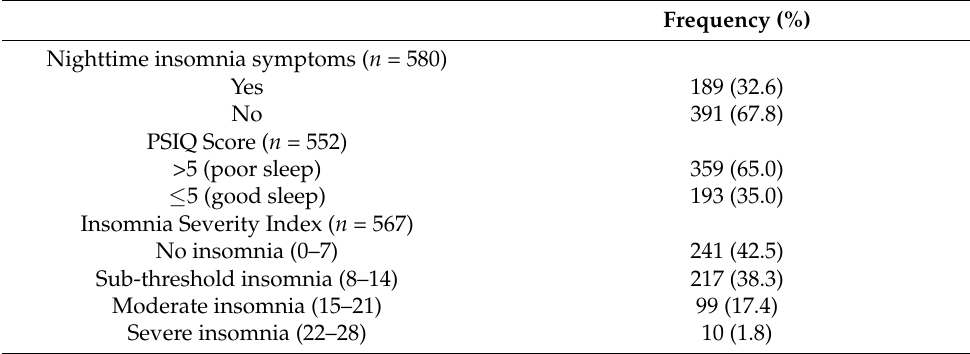
Table 2. Insomnia prevalence using different